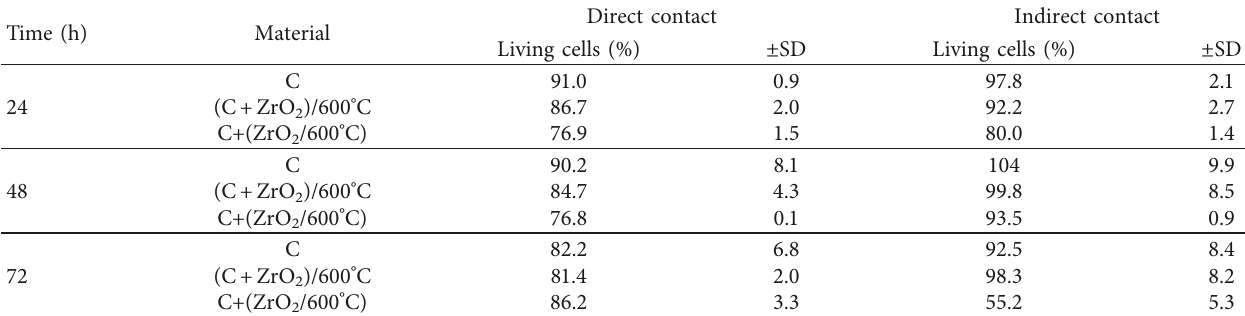
Table 7: Percentage of viable L929 cells after the direct and indirect contact with the tested circles, in vitro. Time (h)